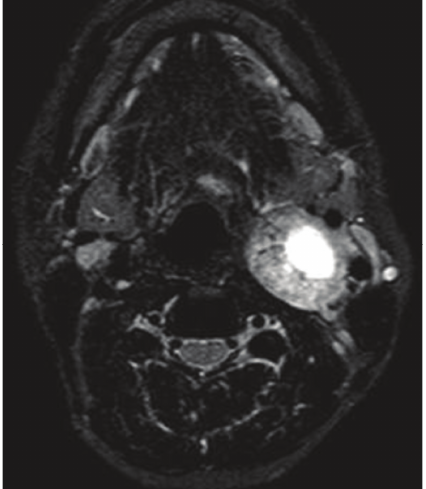
Figure 5: T2-weighted MR image shows hyperintense mass with central cystic